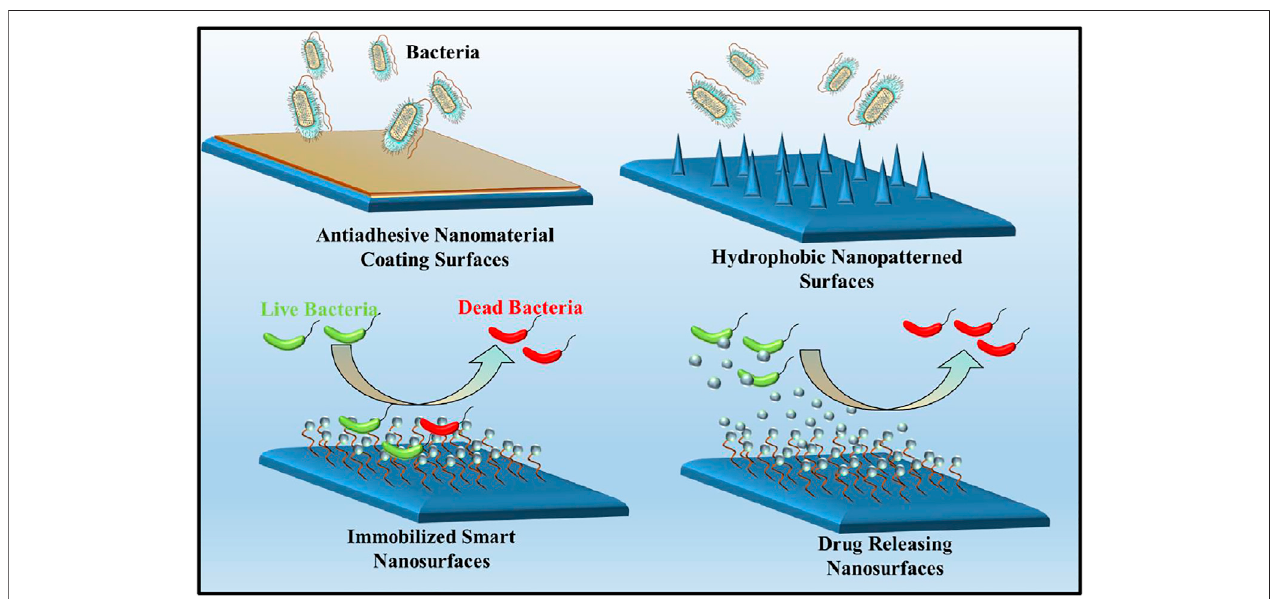
FIGURE 4 | Schematic diagram of surface coating agent to prevent the microbial